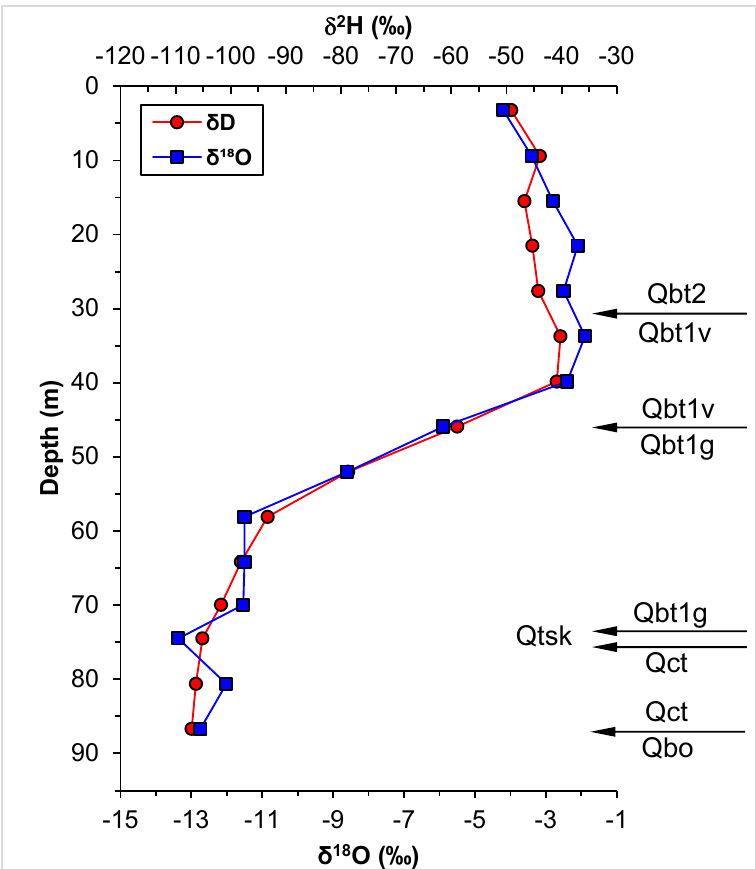
Figure 6. Stable isotope ( δ 18 O and δ 2 H) profiles in Borehole 7, TA-53. Stratigraphic contacts are shown on the right side of the Figure.